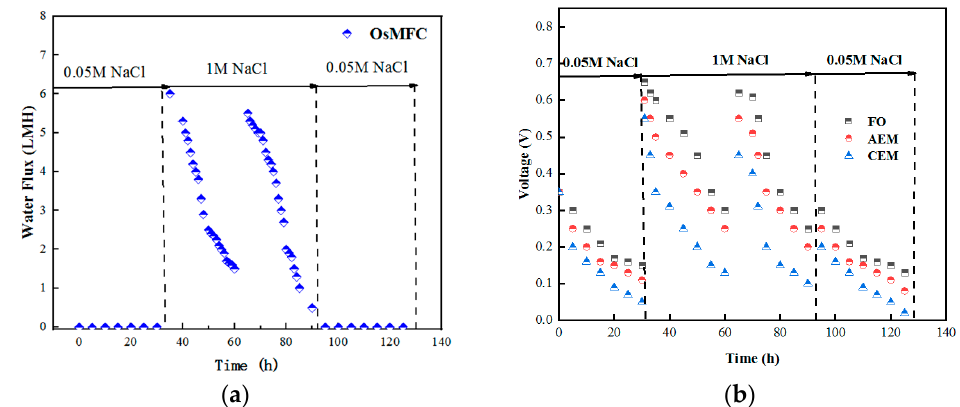
Figure 3 . ( a ) Variation of water flux in the OsMFC system; ( b ) power generation trends of MFC systems with different membrane compositions.